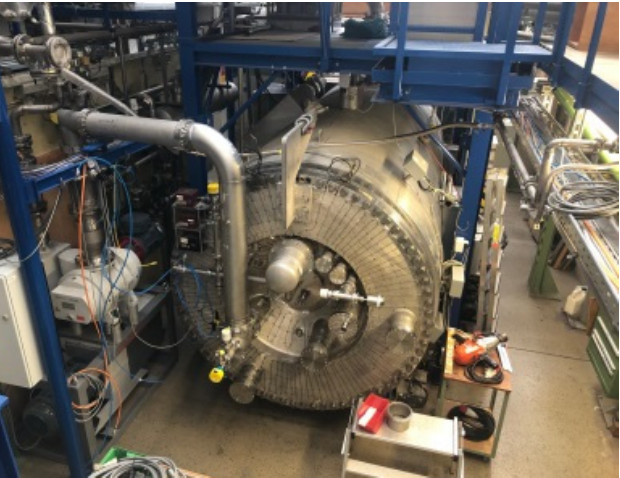
Figure 7. TIMO facility at KIT in the closed position before the completion of all connections at the main flange (pressure reading equipment, exhaust pipes and NEG pump cabling).